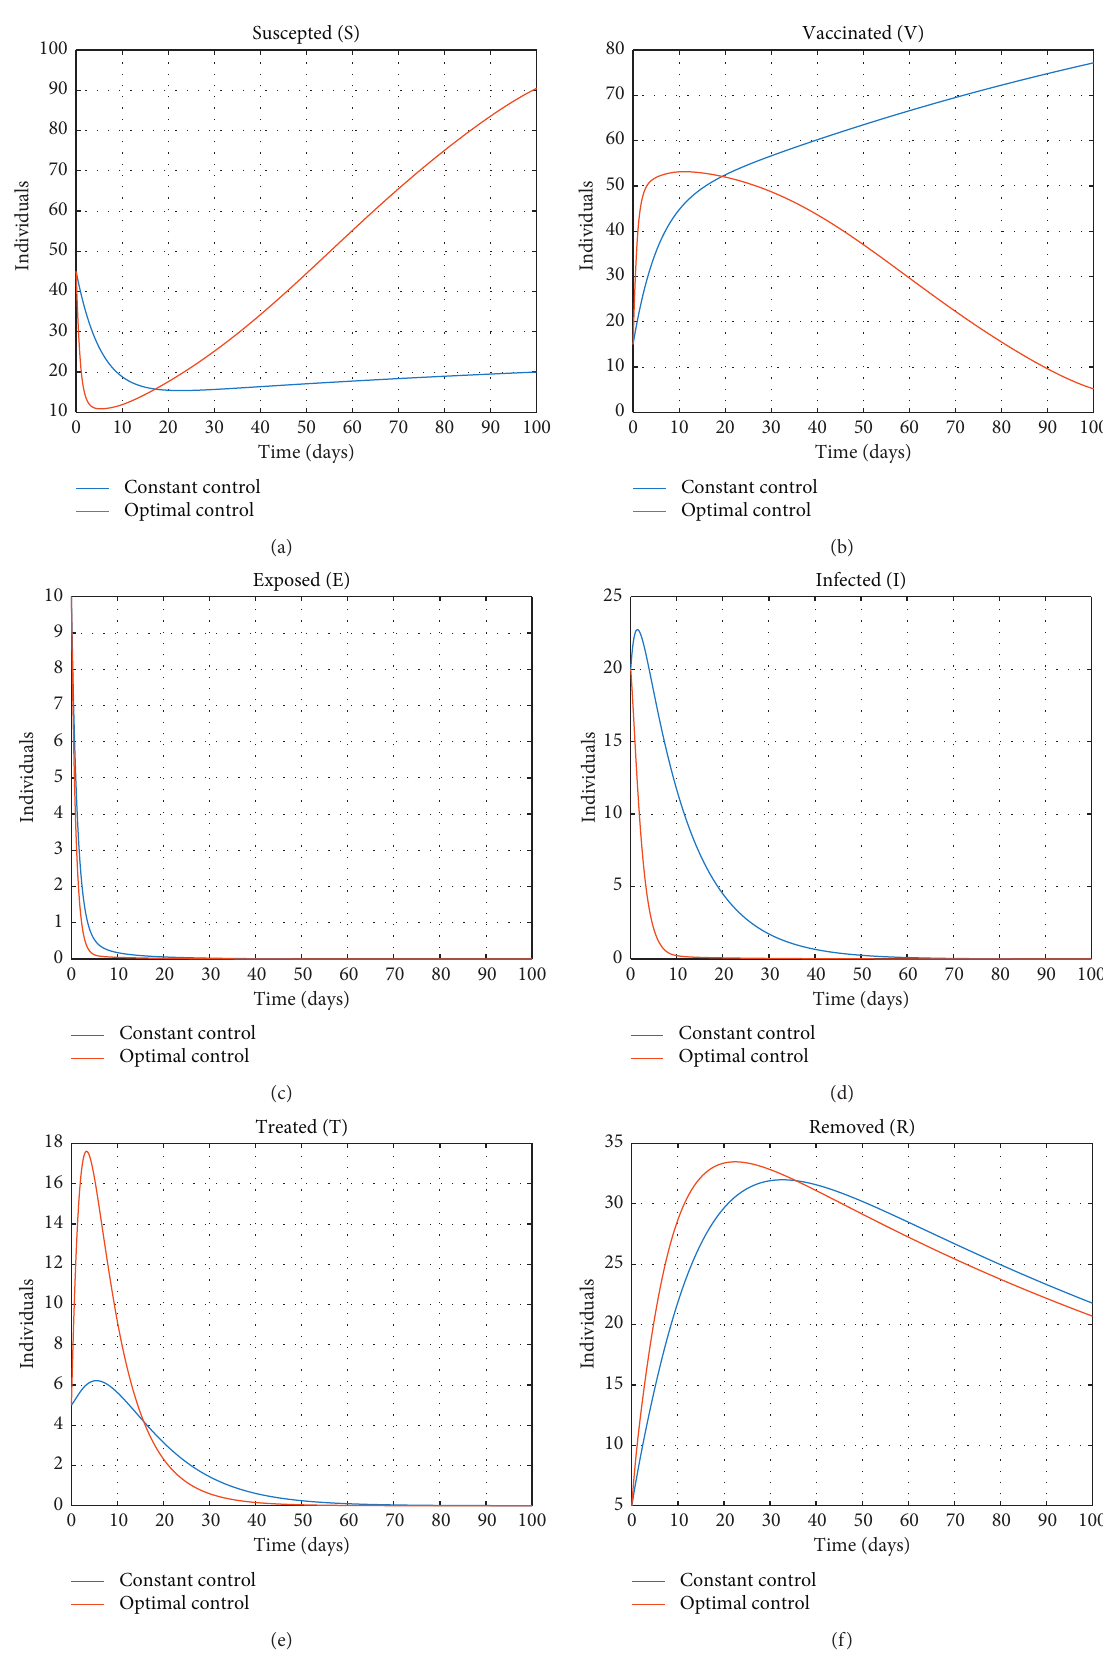
Figure 3: The state variables with constant and optimal